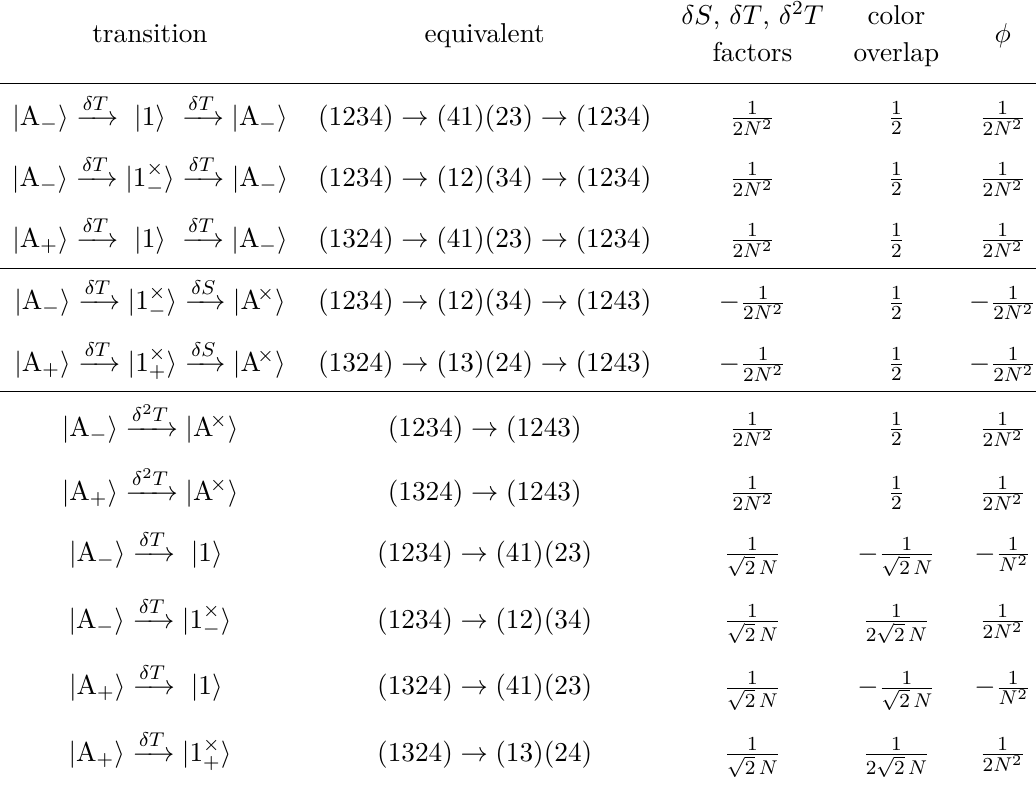
Table 1 . Allowed 4-particle color transitions at order 1 /N 2 for the xy ¯ y ¯ x diagram, along with